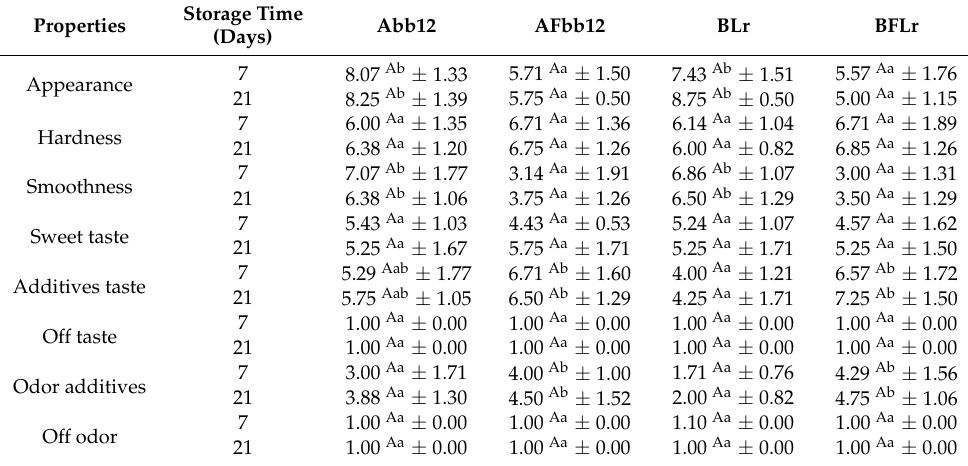
Table 7. Sensory characteristics of ice cream on 7 and 21 days of